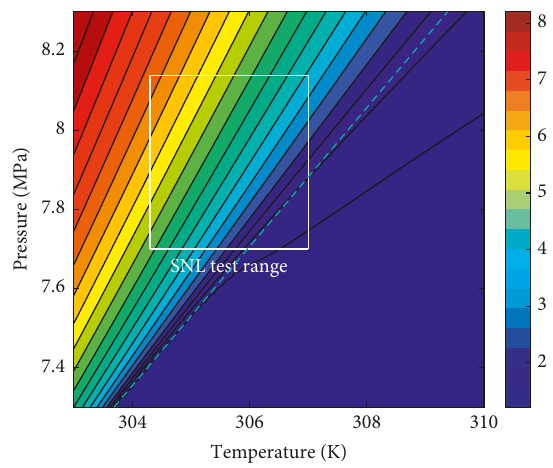
Figure 1: Isentropic exponent of CO